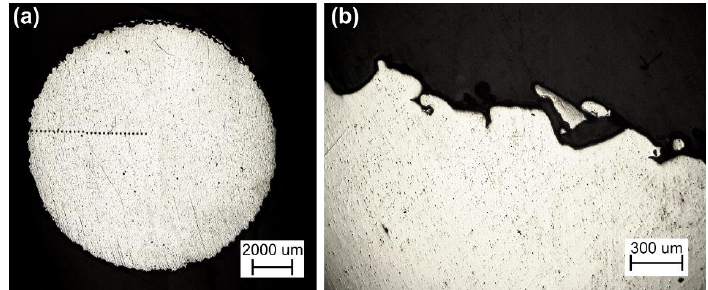
Figure 4. Surface morphology of an as-built sample.